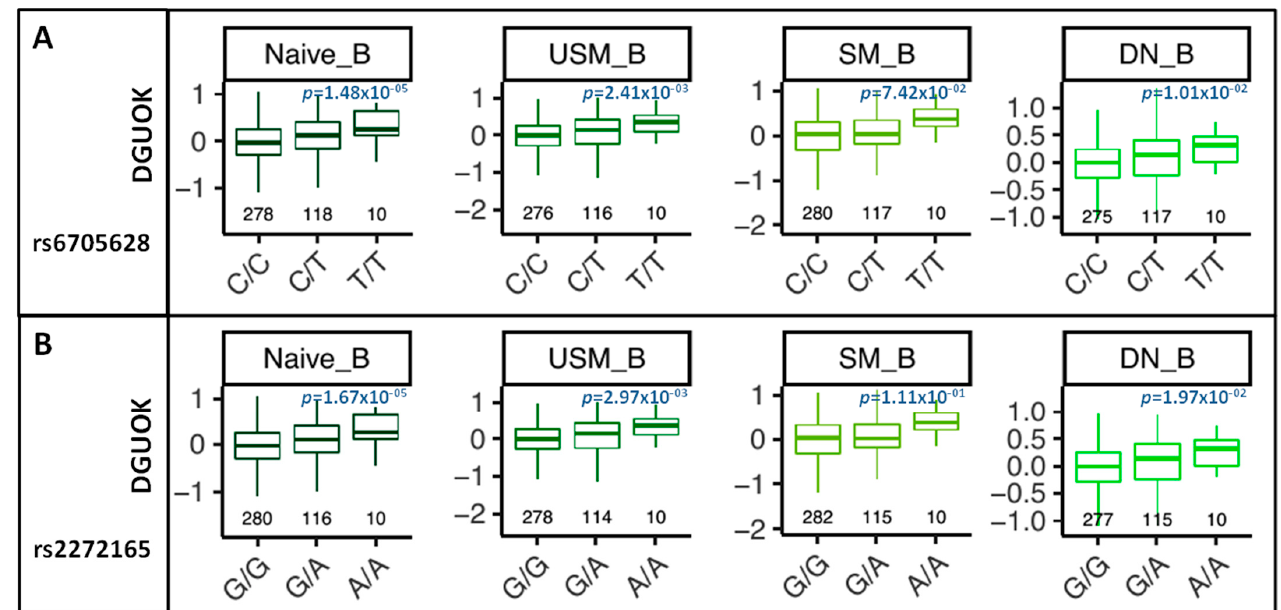
Figure 3. Immune cell type-specific eQTL analysis of the influence of rs6705628 ( A ) and rs2272165 ( B ) on target gene DGUOK (the only target gene) using transcriptome data from Asian samples. The genotypes and their corresponding sample sizes are shown at the bottom of each box plot. (C/C) is the risk for rs6705628 and (G/G) is the risk for rs2272165. USM = unstimulated, SM = stimulated, DN = double negative.